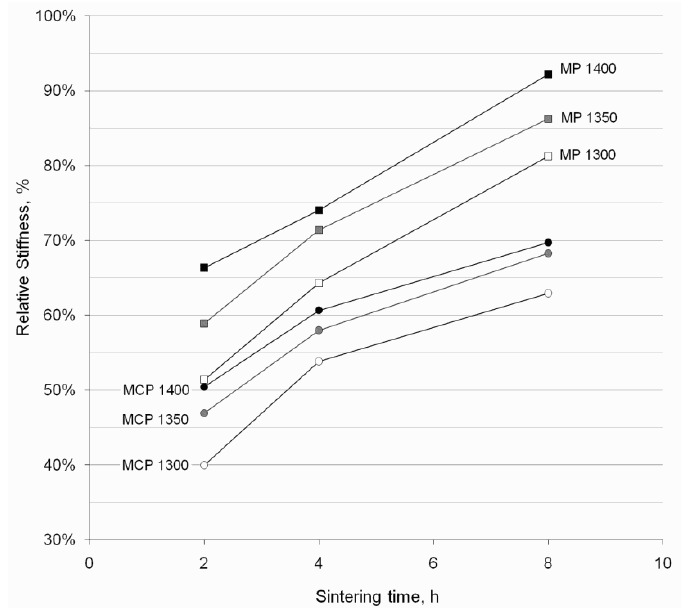
Figure 8. Relative stiffness of the porous Ti–6Al–4V samples developed by microsphere